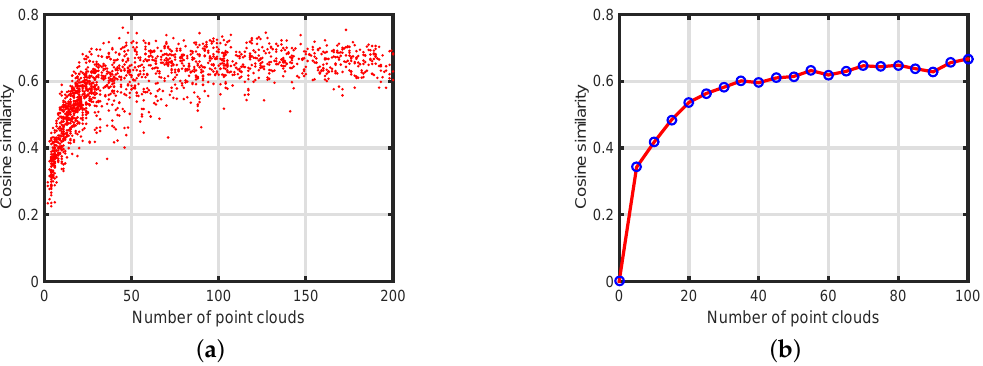
Figure 7. Relationship between number of point clouds and cosine similarity. ( a ) Relationship between number of point clouds and similarity for each sample. ( b ) Statistical curve of relationship between quantized number of point clouds and average similarity.